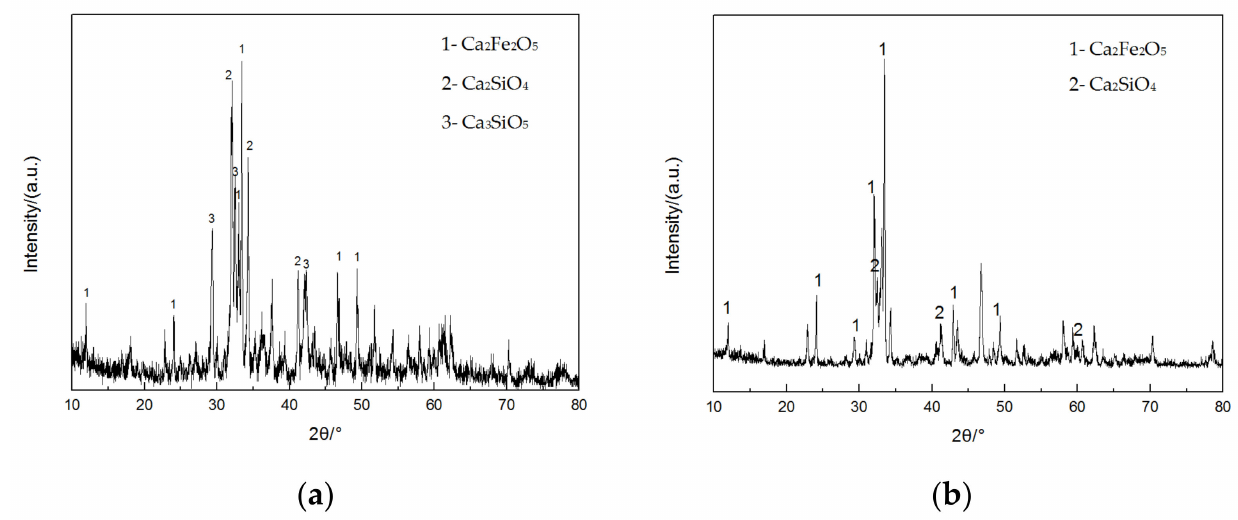
Figure 2. XRD patterns of unfired steel slag ( a ) and 1270 ◦ C fired steel slag ( b